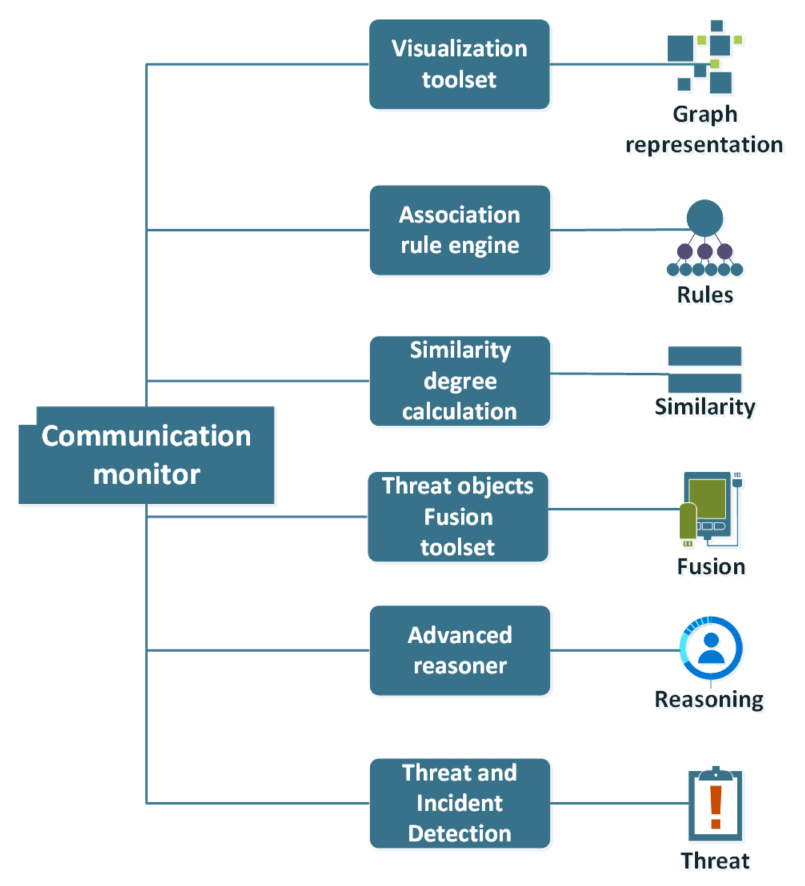
Figure 2. Communication monitor